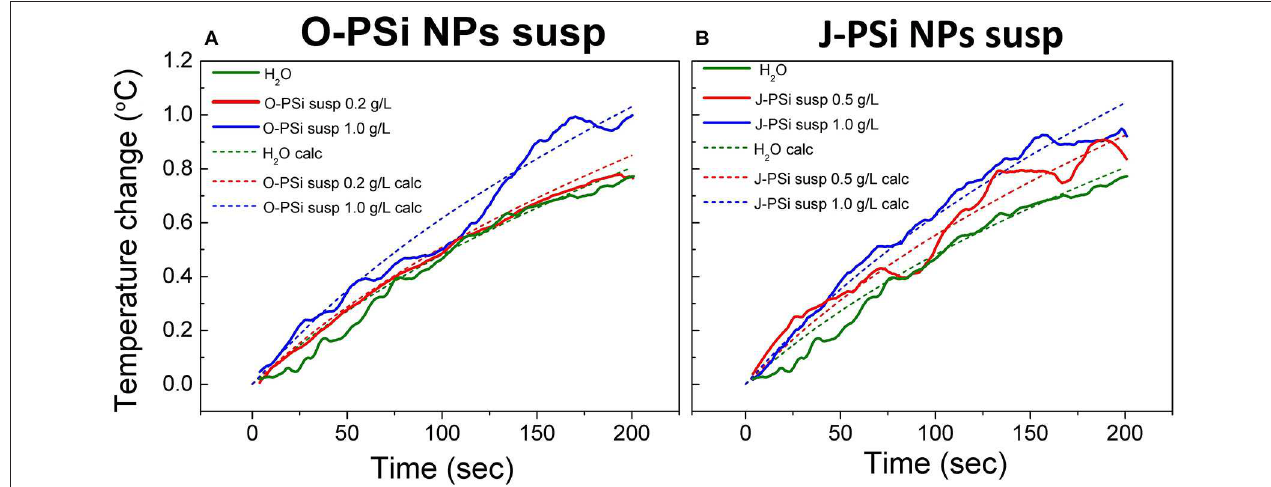
FIGURE 6 | Experimental (solid lines) and theoretically calculated (dashed lines) time dependences of heating in the suspensions of O-PSi NPs (A) and J-PSi NPs (B) exposed to the US with the intensity of 11.4 W/cm 2 at different NP concentrations.